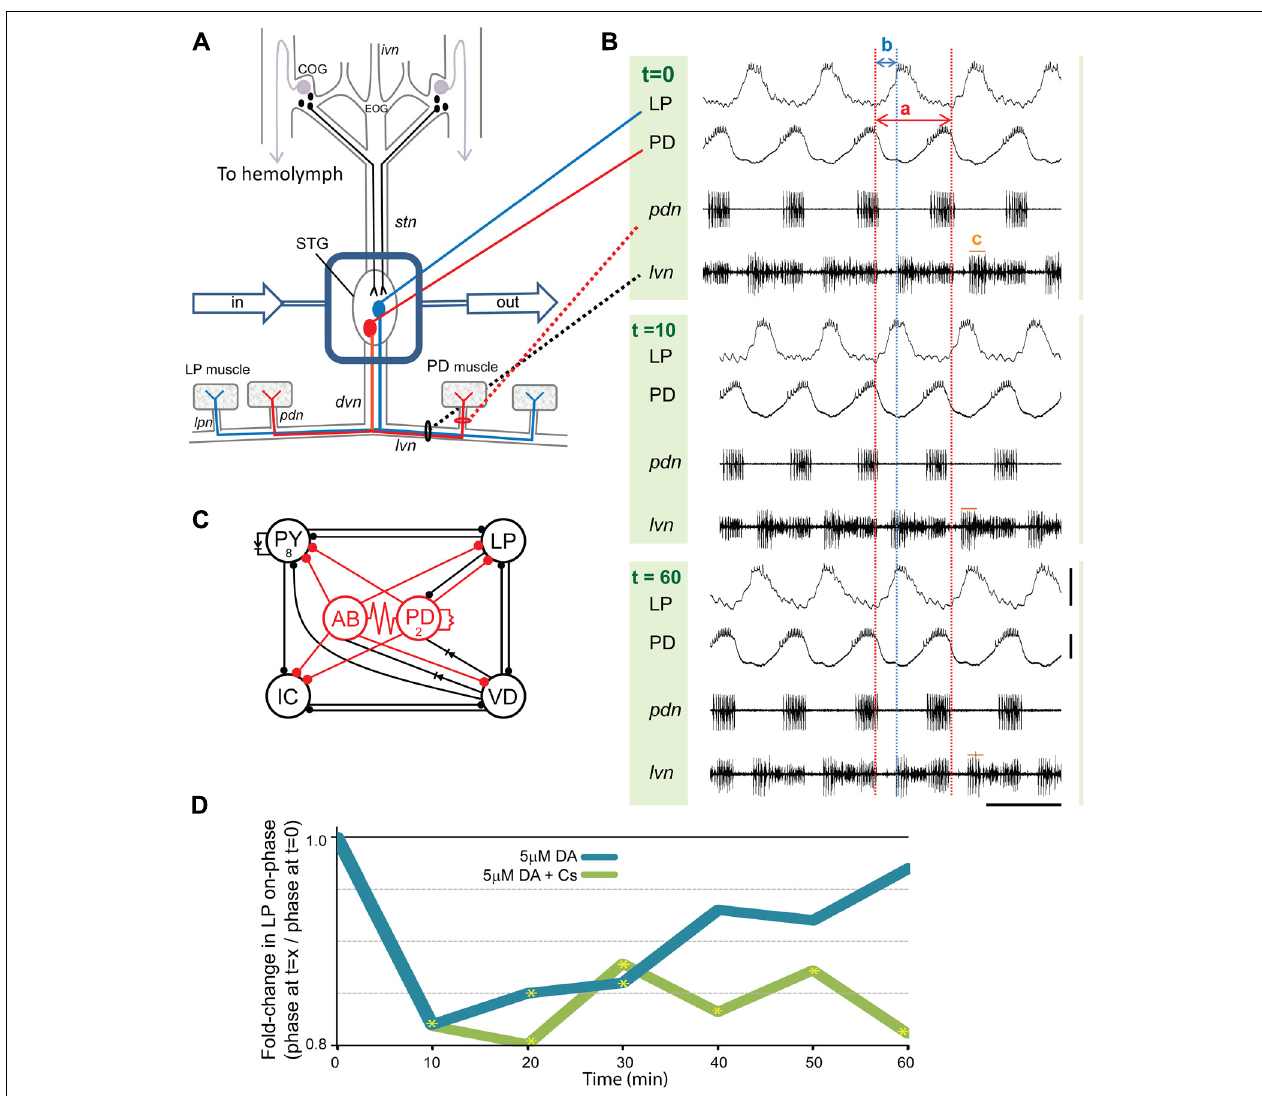
FIGURE 1 | Phase recovery in the pyloric network. (A) In situ preparation: the stomatogastric nervous system (STNS) is dissected and pinned in a dish. The commissural ganglia (CoGs) contain DA neurons that project to the STG (black) and L-cells, which are the source of neurohormonal DA (purple).The well surrounding the STG (blue rectangle) is continuously superfused with saline (in/out arrows).There are ∼ 30 neurons in the STG.The pyloric network comprises 14 STG neurons; two are drawn: pyloric dilator (PD, red), lateral pyloric (LP, blue). Network neurons interact locally within the STG and can project axons to striated muscles surrounding the foregut.The diagram shows that PD and LP neurons project their axons through identified nerves to innervate muscles (rectangles). (B) Spontaneous pyloric network output from one experiment during a 1 h 5 μ M DA application: one set of traces comprises two intra-cellular recordings (top) and two extra-cellular recordings (bottom) from the in situ preparation diagrammed in (A) .The three sets of traces represent recordings from the indicated time points, in minutes, directly before and after the start of DA application. Red and blue dashed lines reveal how cycle period and LP-on delay change with time.The two red lines demarcate one cycle. Cycle period (a) is defined as the time between the last spike in one PD burst and the last spike in the subsequent PD burst. Note that for each time point the last spike in the first PD burst is aligned with the first red line; however, the last spike in the second PD burst is not aligned with the second red line except at t = 0.This is because 5 μ M DA produces a